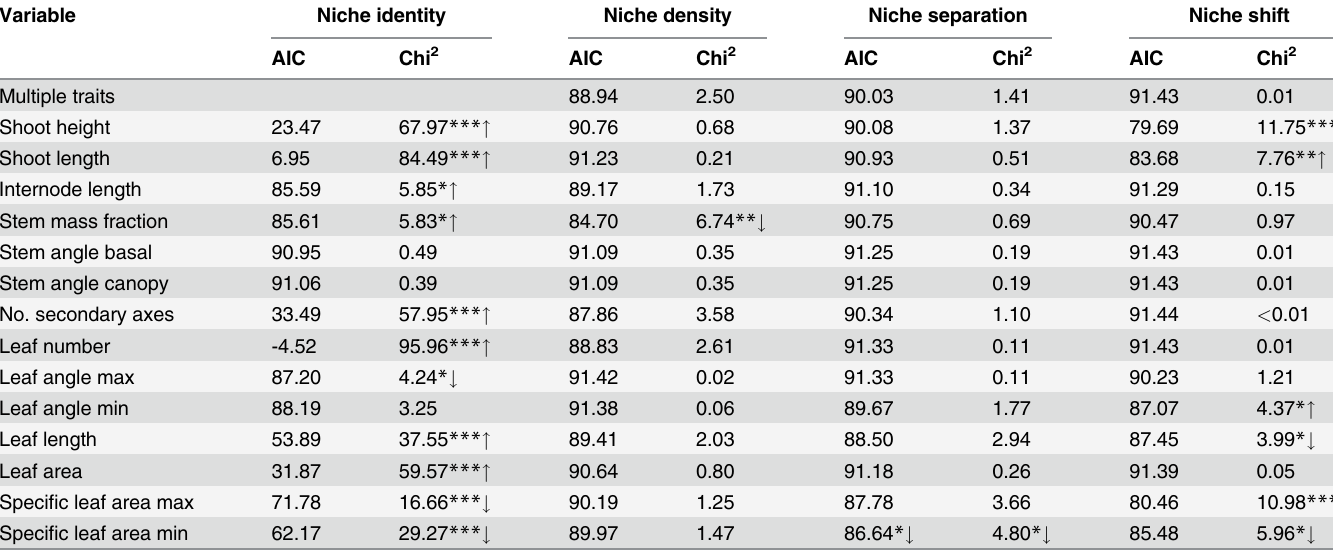
Alternative models were fi tted with single predictor variables. Listed are AIC and Chi 2 results of likelihood-ratio tests that were applied to assess model improvement and the statistical signi fi cance of the explanatory terms,